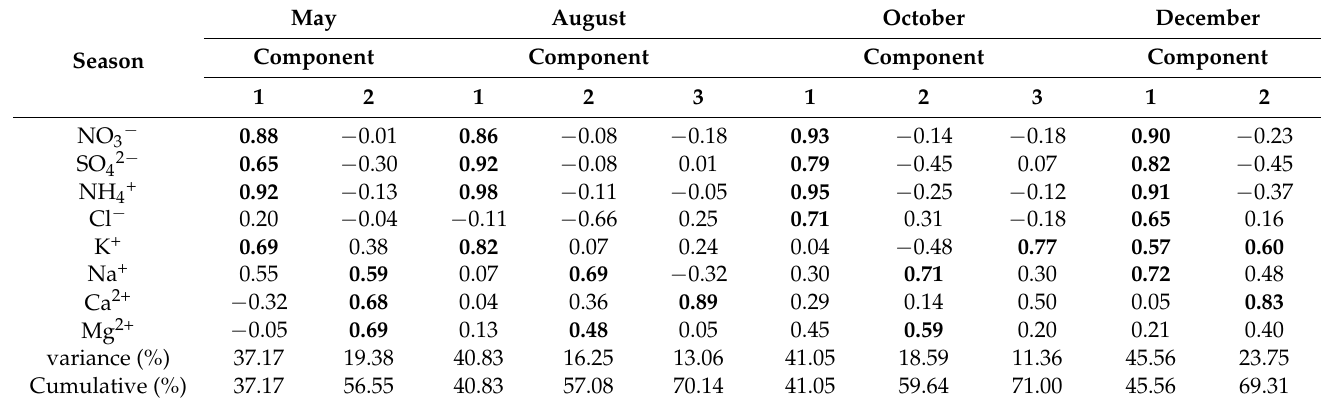
Table 4. Results of the principal component analysis for WSIIs in PM 2.5 in